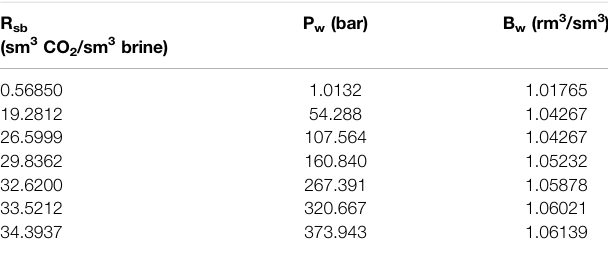
TABLE 2| CO 2 solubility(R sb )andCO 2 formationvolumefactor (B w )asfunctionof pressure (P w ) (Chang et al., 1996).